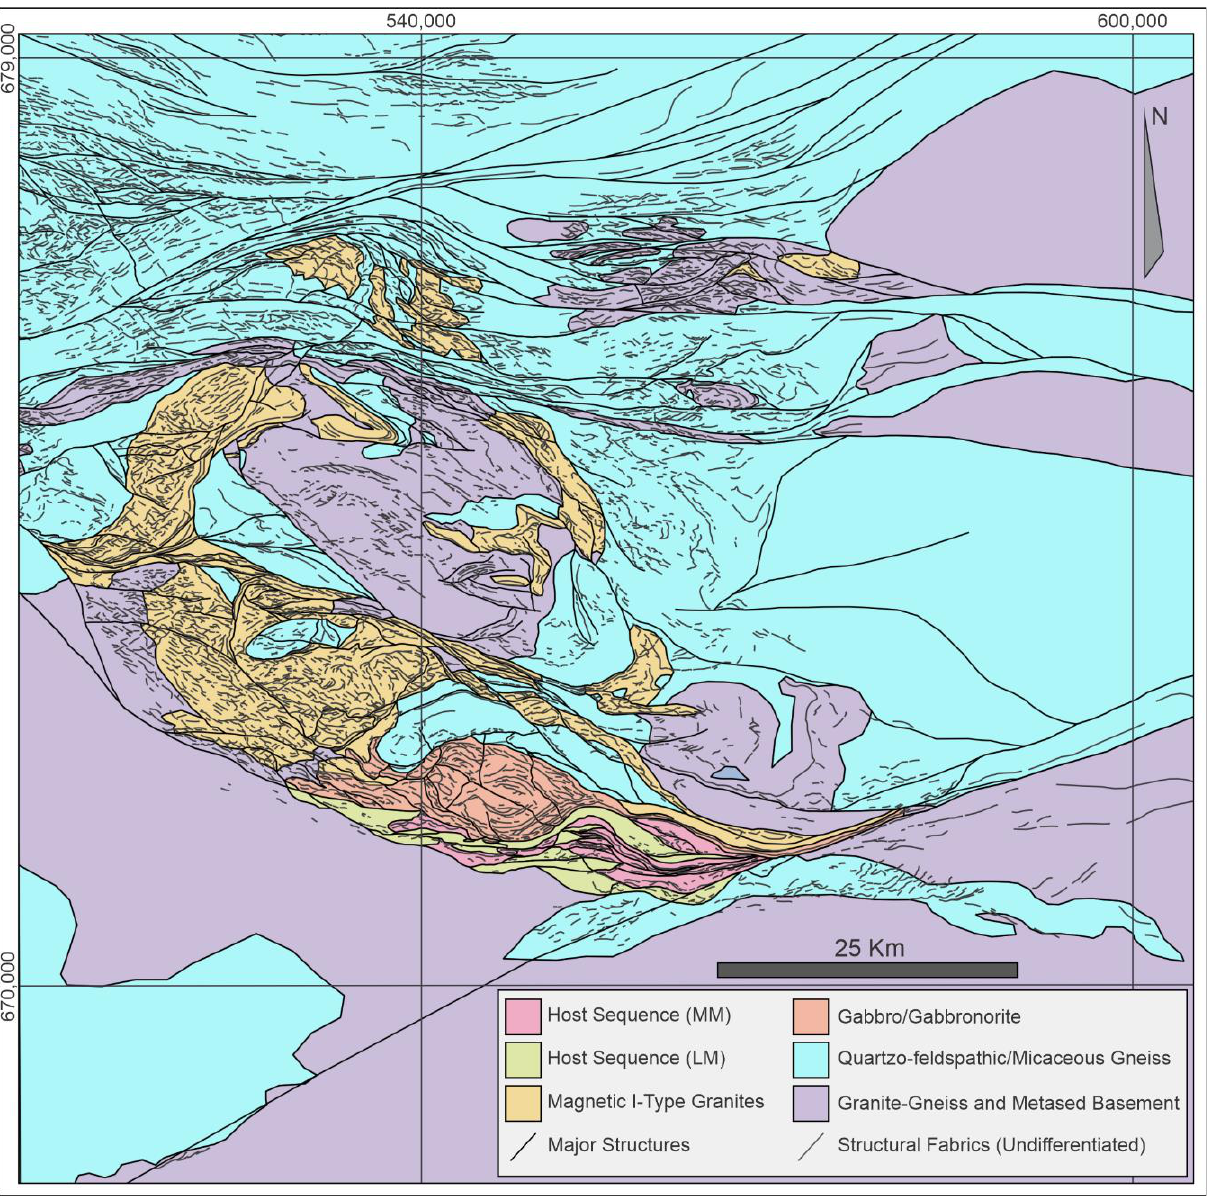
Figure 3. Structural and lithological re-interpretation of the Mt. Woods Inlier. Lithological classification broadly follows that of [68].